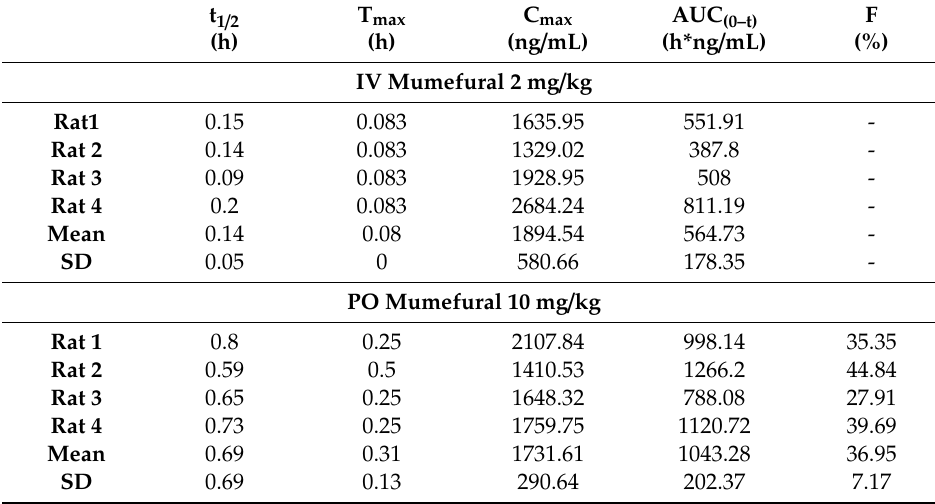
Table 3. Plasma pharmacokinetic parameters of MF in SD